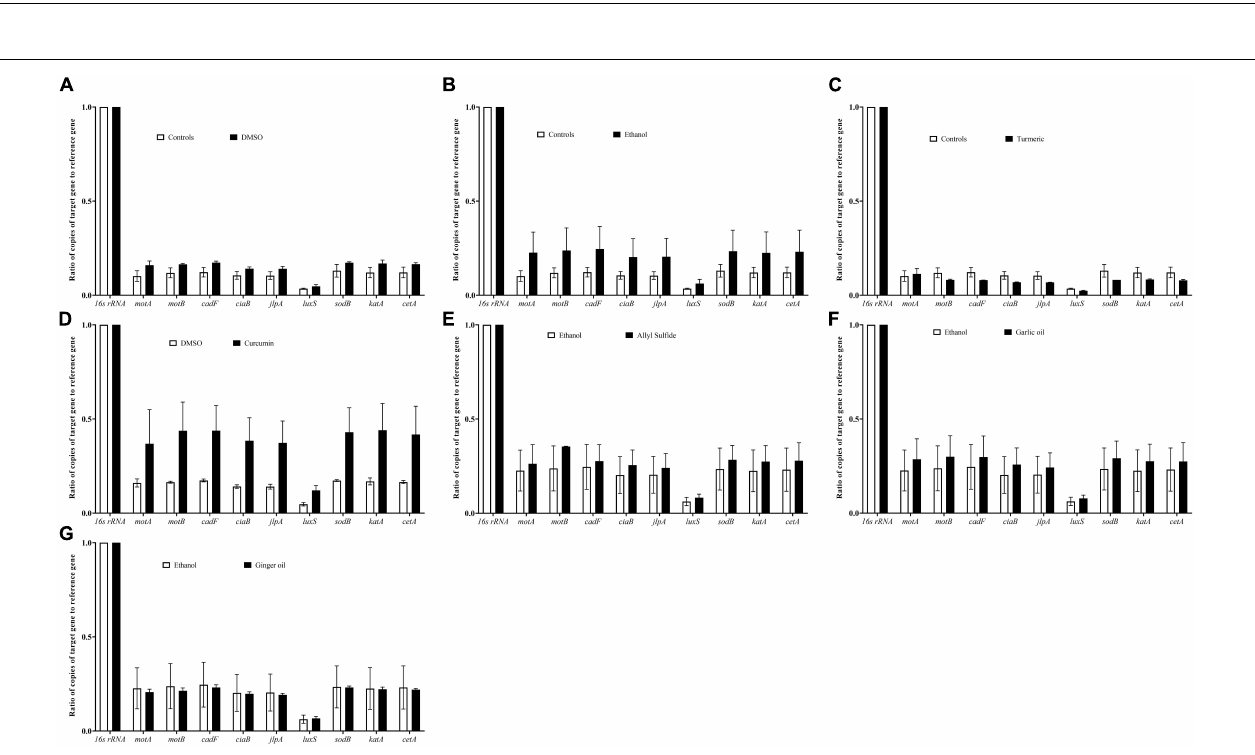
FIGURE 8 | Effect of DMSO (A) , ethanol (B) , turmeric (C) , curcumin (D) , allyl sulfide (E) , garlic oil (F) , and ginger oil (G) at SIC dose on expression of C. jejuni S-8 genes critical for survival and virulence. C. jejuni ( ∼ 6.0 Log CFU/ml) in the presence of SIC of phytochemicals was incubated at 42 ◦ C for 12 h followed by RNA extraction and complementary DNA (cDNA) synthesis. Digital droplet PCR (ddPCR) was conducted with 16S-rRNA serving as endogenous control. Results are averages of three biological replications (mean and SEM).